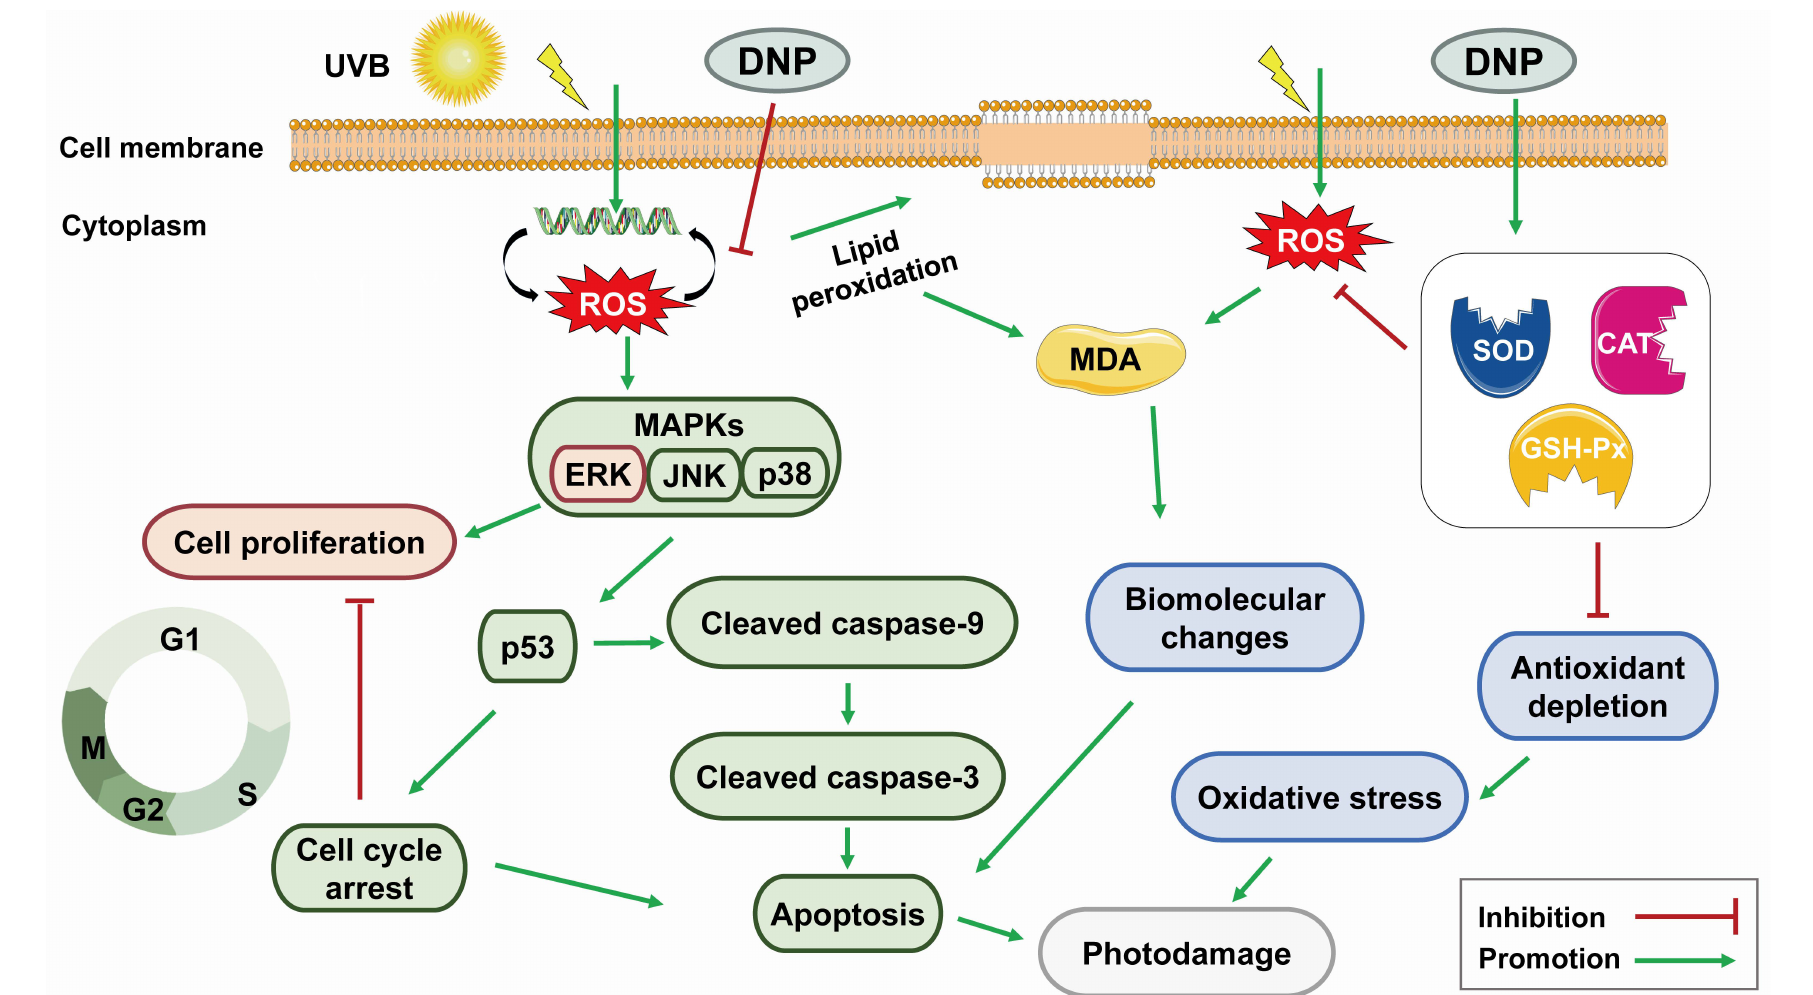
Figure 9. Potential mechanism of DNP in ameliorating the UVB-induced photodamage of HaCaT